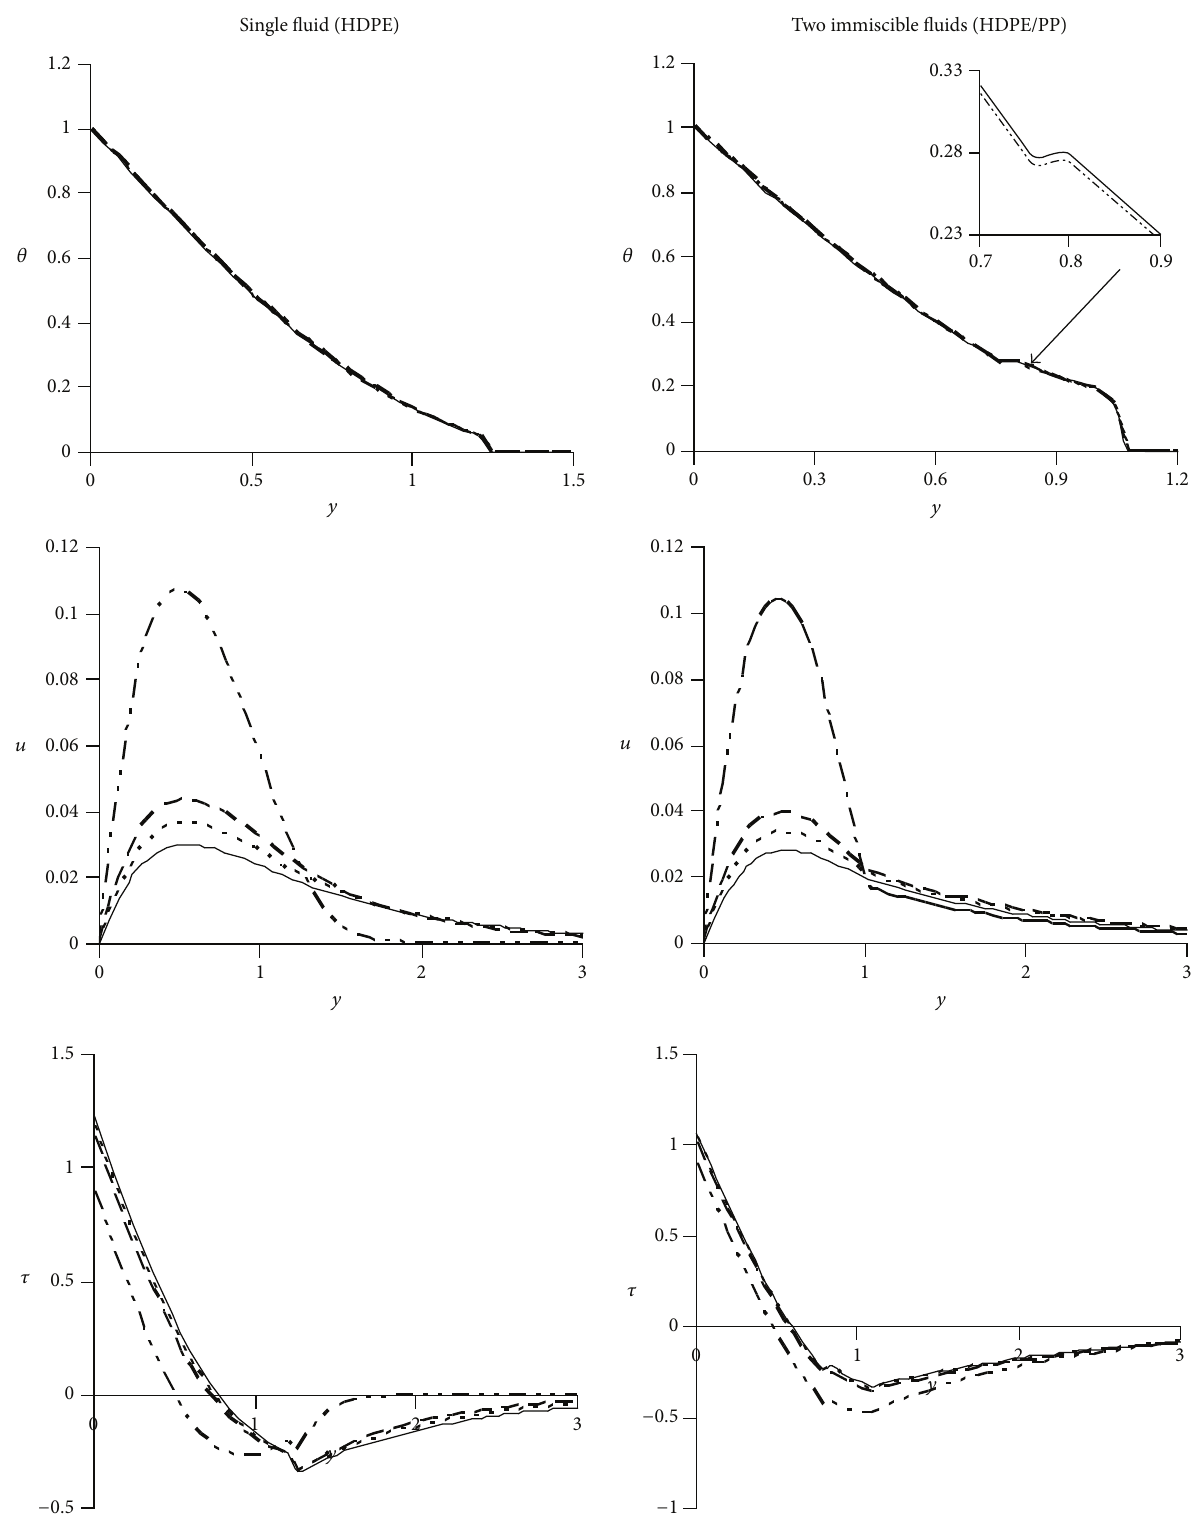
Figure 4: Temperature, velocity, and stress distribution for 𝛼 1 = 𝛼 2 = 𝛽 2 = 1 , 𝑡 = 0.09 , and 𝛽 1 = { 0.0 (– ⋅ ⋅ –); 0.8 (–– –); 0.9 ( ⋅ ⋅ ⋅ ); 1.0 (— )}